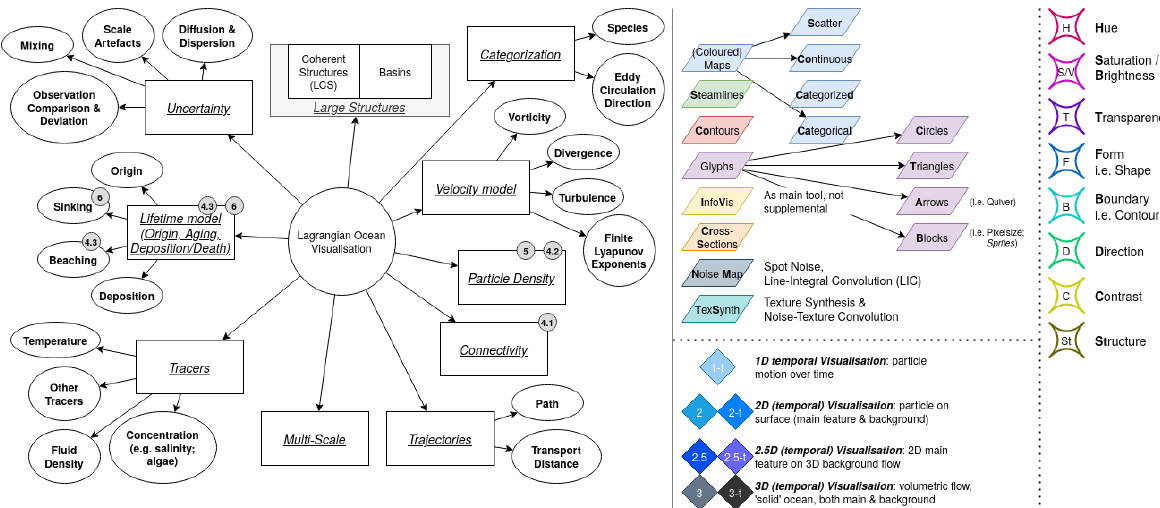
Figure 1. Taxonomy for Lagrangian ocean analysis study objectives (left), visualisation techniques (mid-top), graphical dimensions (mid bottom) and visual channels (right). Info-bubbles attached to individual study objective boxes indicate the sections in this article in which those subjects are discussed by